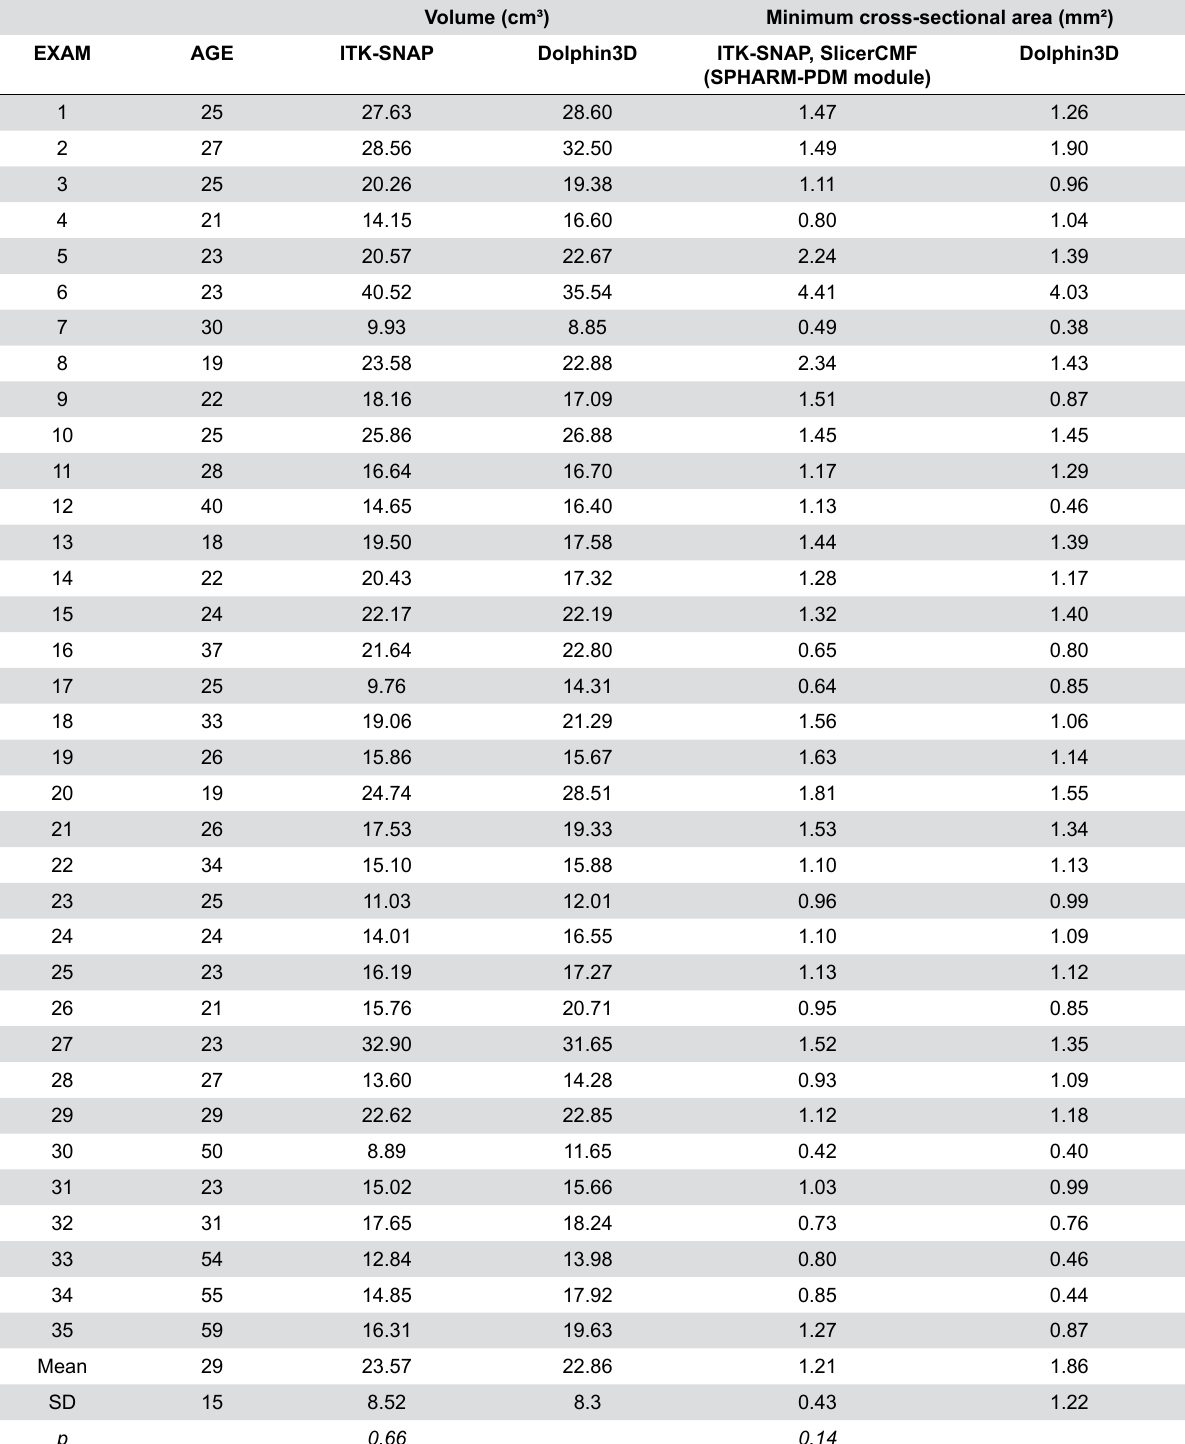
Table 1- Volume and minimum cross-sectional area values obtained by the applications Dolphin3D, ITK-SNAP, and SlicerCMF with SPHARM-PDM